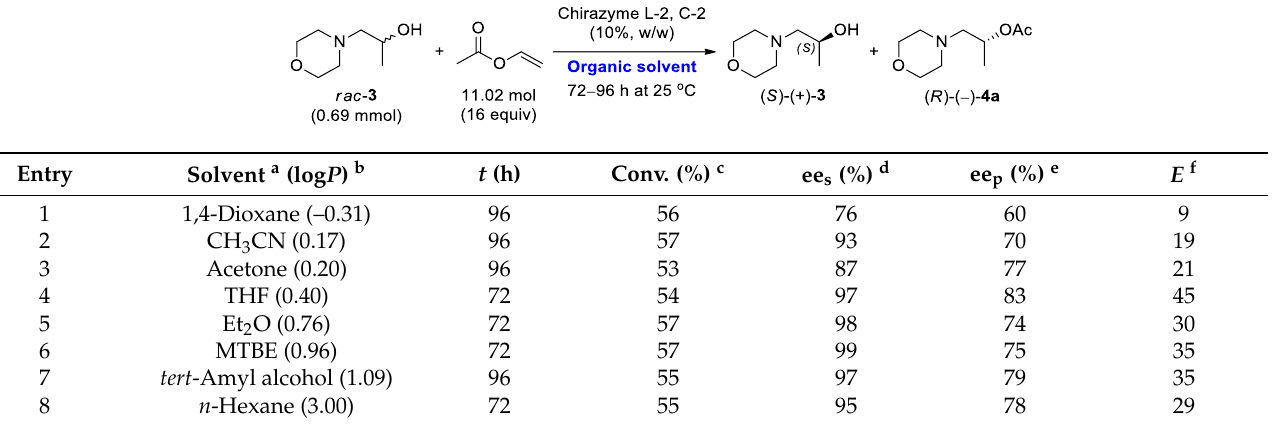
Table 2. Solvent screening for Chirazyme L-2, C-2-catalyzed enantioselective acetylation of rac - 3 using vinyl acetate under kinetically controlled conditions.